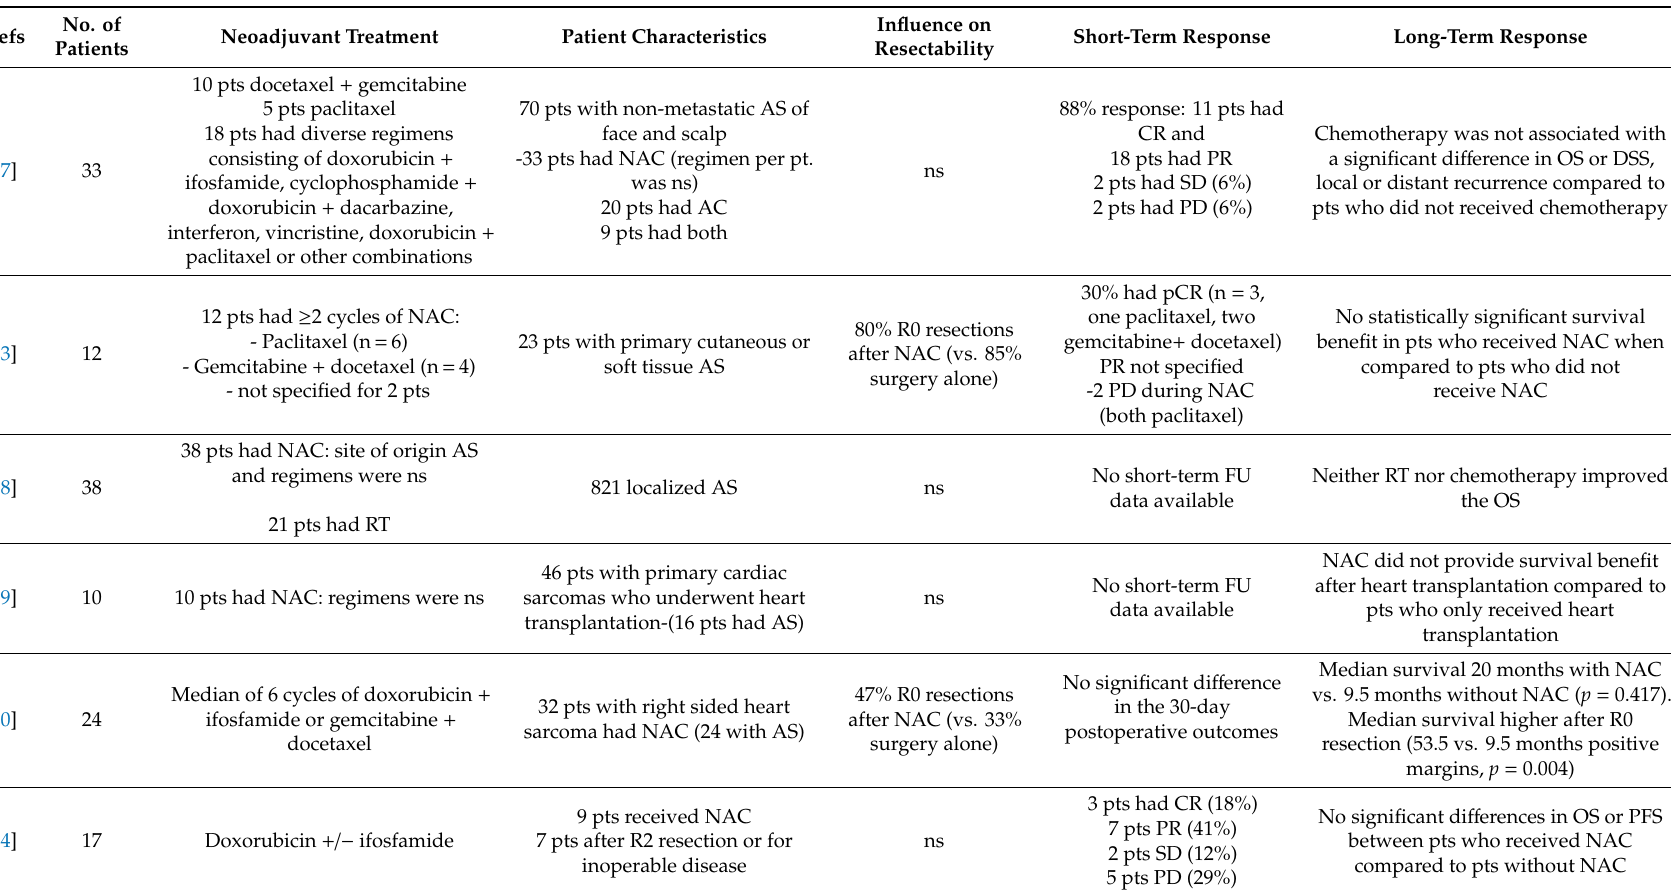
Table 1. Overview of responses to neoadjuvant systemic treatment in angiosarcoma patients – retrospective cohort